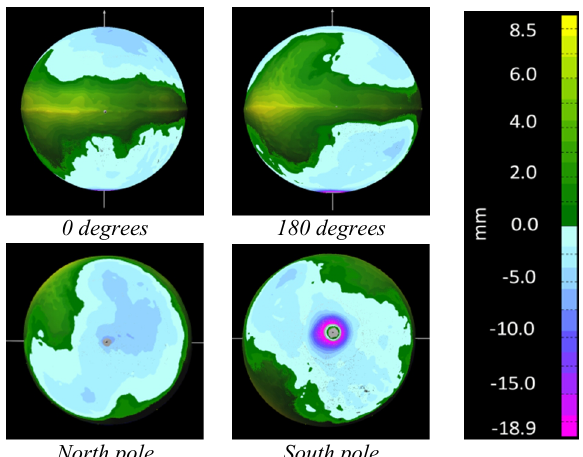
Fig. 8: Error maps between the best-fitted sphere and the globe’s shape.